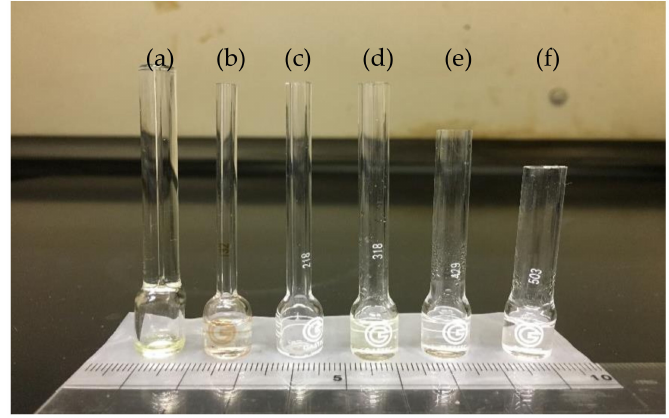
Figure 2. D-tubes for gas generator: ( a ) D-001, ( b ) D-01, ( c ) D-02, ( d ) D-03, ( e ) D-04, ( f ) D-05.